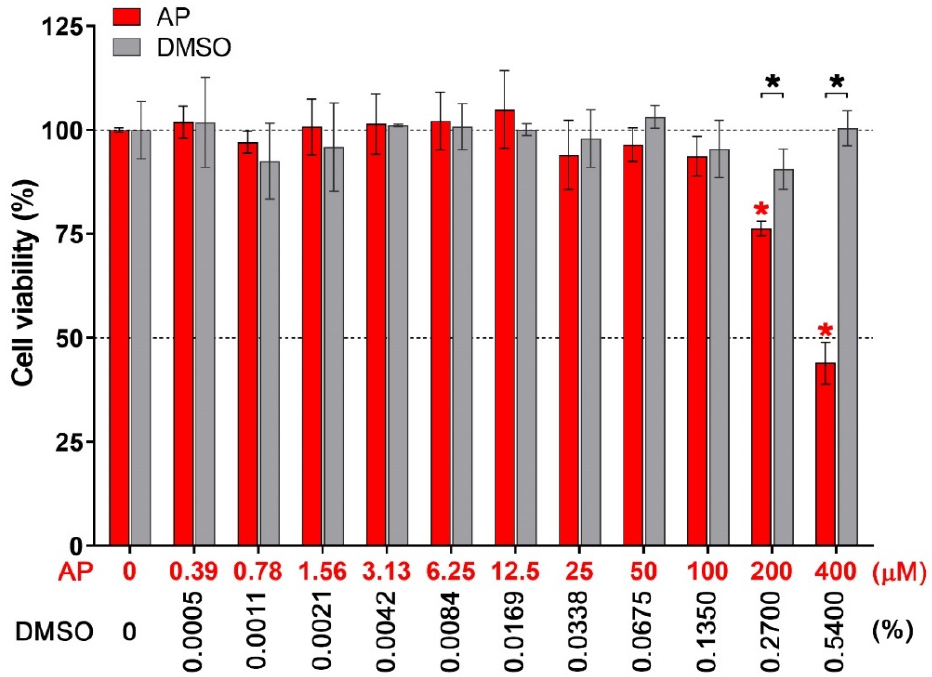
Figure 1. Effects of AP on THP-1 macrophage viability. TPA-activated THP-1 cells were treated with varied concentrations of AP (0–400 µ M) for 48 h and subjected to MTT assay. DMSO (0–0.5400%) was used as a vehicle control. Data were obtained from three independent experiments. * p < 0.05 (red asterisk (compared with the untreated group), and black asterisk (compared with the DMSO- treated